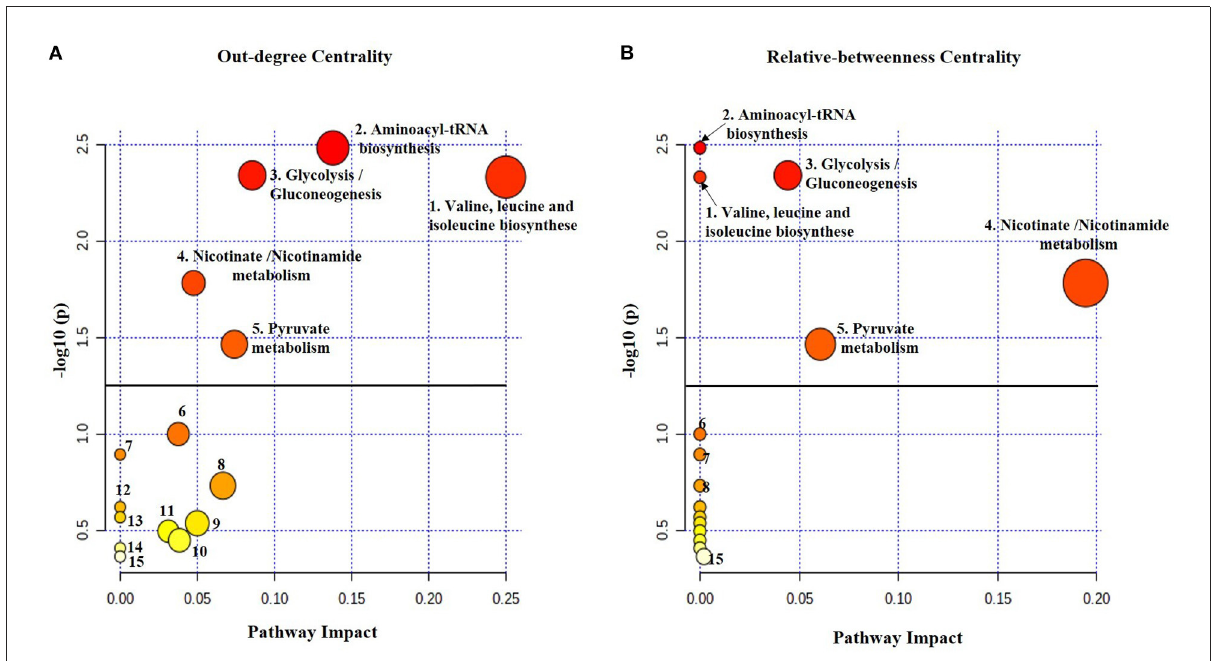
FIGURE3 The metabolome view map of altered metabolic pathways identified in breath samples from MDD patients compared with healthy controls conducted by MetaboAnalyst tool. The significant pathways with the enrichment analysis are (1) Valine, leucine and isoleucine biosynthesis, (2) Aminoacyl-tRNA biosynthesis, (3) Glycolysis and gluconeogenesis, (4) Nicotinate and nicotinamide and (5) Pyruvate metabolism. The topological pathway analysis shows different impact factors of the significant altered pathways using (A) out-degree centrality and (B) relative betweenness centrality. The matched nodes show varied heat map colors and is based on p-value while the node radius is determined based on the pathway impact values. The bold lines indicate the significance level of a p -value = 0.05. The pathways under the bold line are probable altered pathways but not significant (6) Valine, leucine and isoleucine degradation, (7) Biotin metabolism, (8) Butanoate metabolism, (9) Lysine degradation, (10) Glyoxylate and dicarboxylate, (11) alanine, aspartate and glutamate metabolism, (12) Selenocompound metabolism, (13) Propanoate metabolism, (14) Glycerophospholipid metabolism and (15) Tryptophan